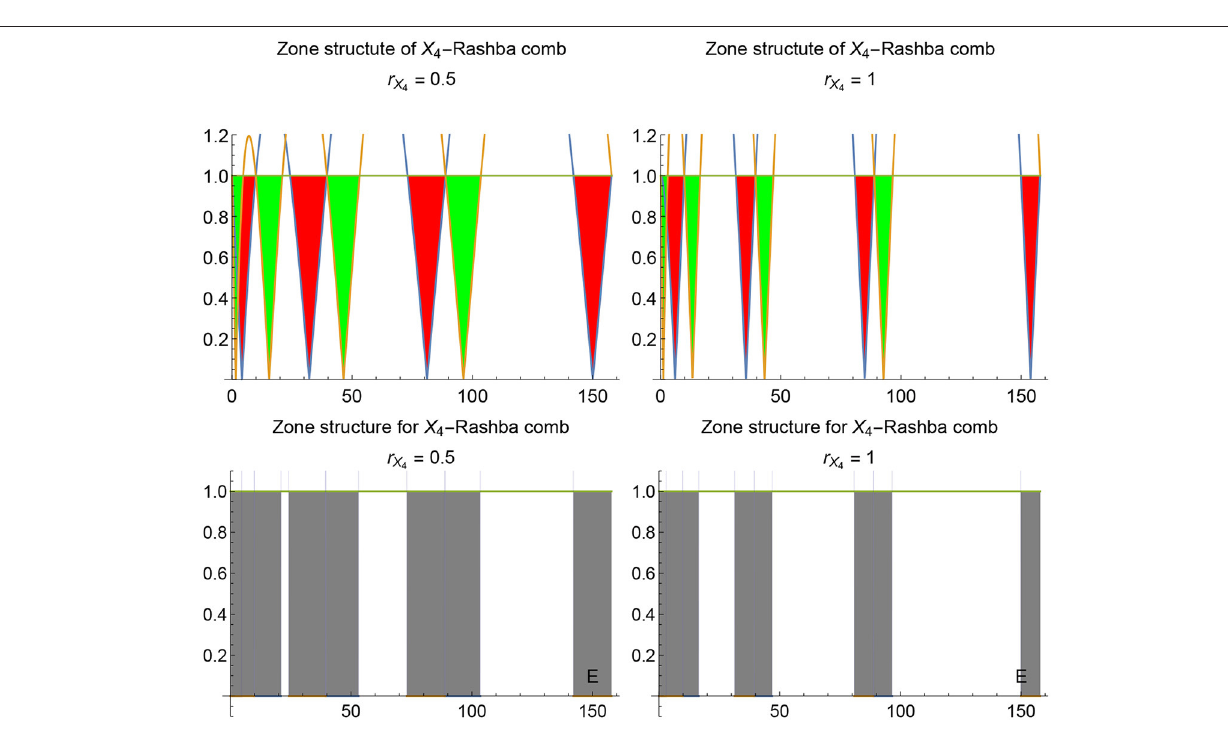
Frontiers in Physics |